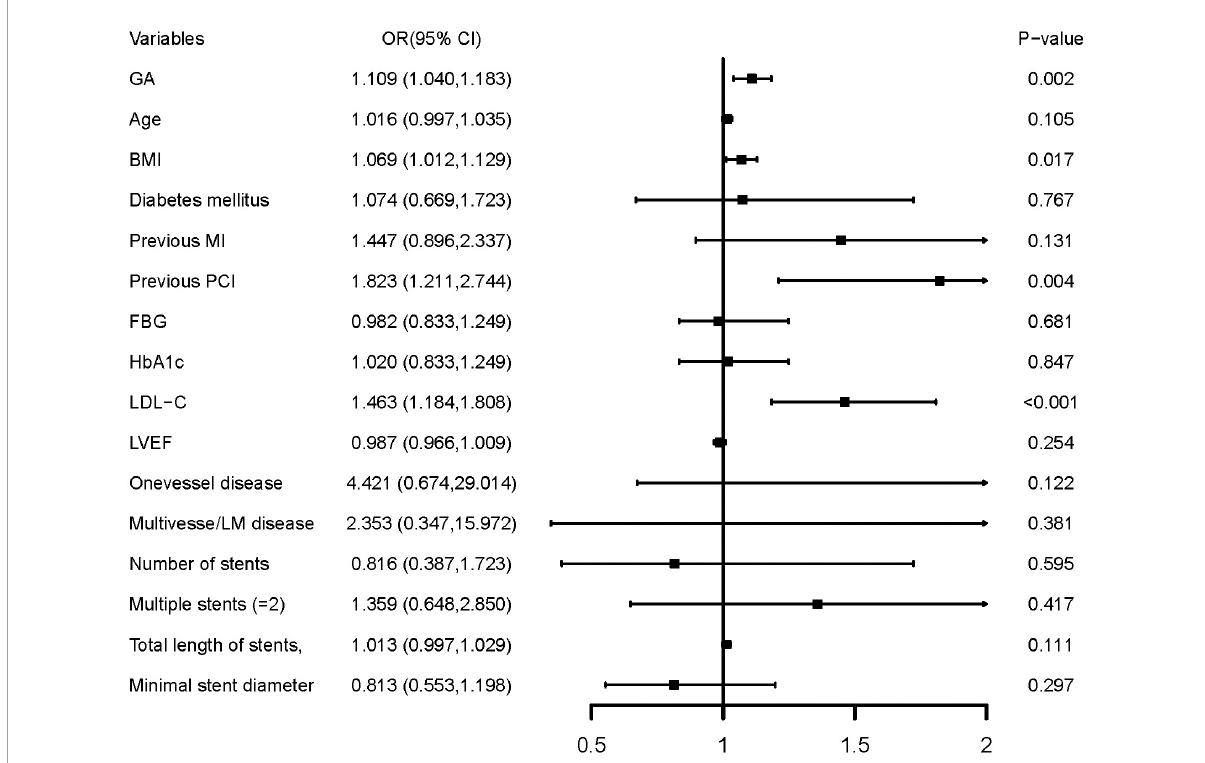
FIGURE2 Forest plot of the multivariable logistic regression analysis model in patients with ACS evaluating the association of the GA and the risk of DES-ISR. ACS, acute coronary syndrome; GA, glycated albumin; DES, drug-eluting stent; ISR, in-stent restenosis; BMI, body mass index; MI, myocardial infarction; PCI, percutaneous coronary intervention; FBG, fasting blood glucose; HbA1c, glycosylated hemoglobin A1c; LDL-C, low-density lipoprotein cholesterol; LVEF, left ventricular ejection fraction; OR, odds ratio; CI, confidence